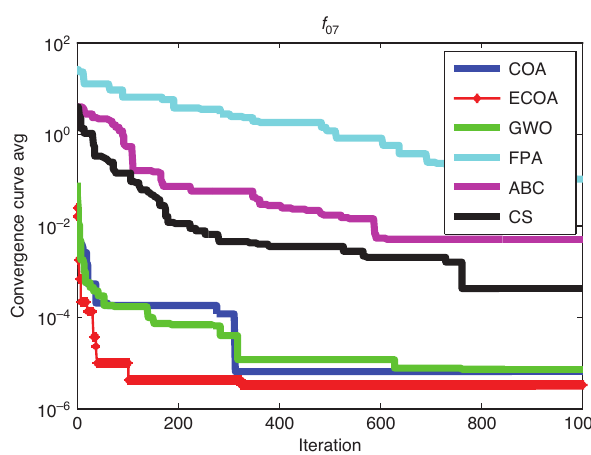
Figure 13: D = 30, Evolution Curves of Fitness Value for f